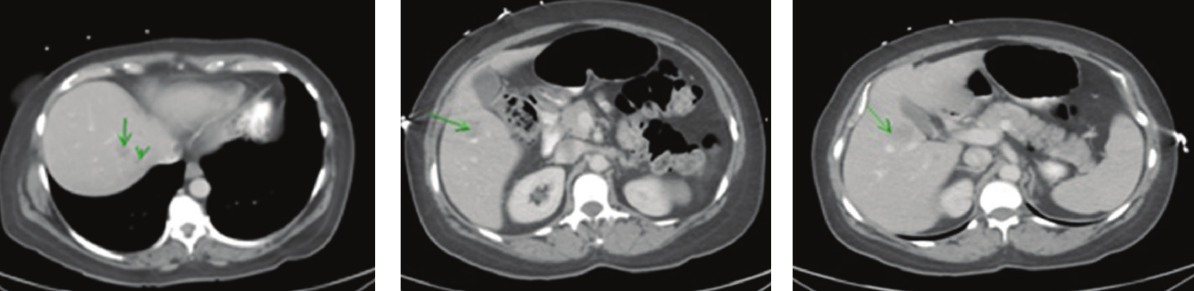
Figure 2: Computed tomography of the abdomen showing multiple metastatic lesions in various segments of the